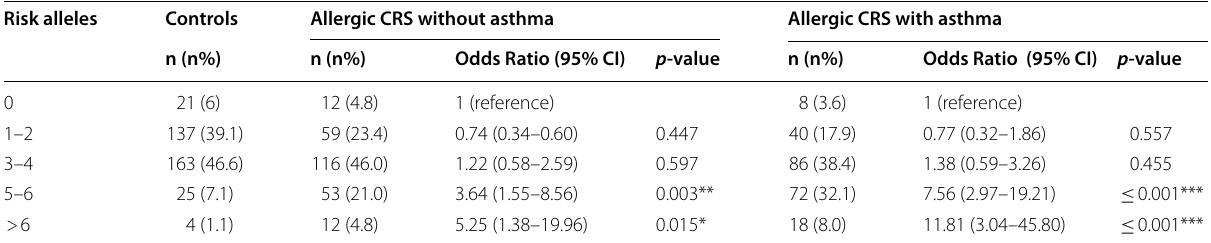
Table 6 Distribution of cumulative risk alleles of CYP1A1 , CYP1A2 and GSTP genes in cases with allergic CRS, and allergic CRS with asthma and controls